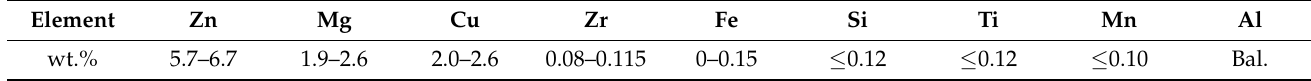
Table 1. The chemical composition of 7050 aluminium alloy. Element Zn Mg Cu Zr Fe wt.%